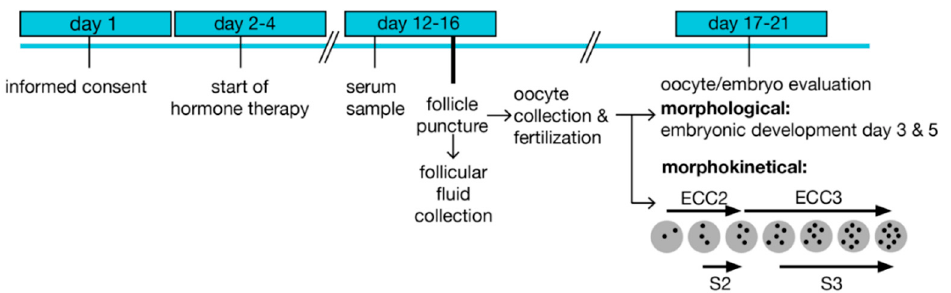
Figure 1. Treatment scheme and sample preparation. Enrolment started on day 1 before the initiation of hormone treatment. A serum sample was prepared prior to follicular puncture and follicular fluid collection. Oocytes and embryos were evaluated based on morphological characteristics, and embryos were cultured in time-lapse systems after fertilization for recording morphokinetic times. ECC; embryo cell cycle, s; synchronization within an ECC. Embryo quality was evaluated at development day 3 with regards to the symmetry of the cells and the percentage of fragmentation. The expansion of the blastocyst, the quality of the inner cell mass (ICM), and the quality of the trophectoderm were determined on embryonic day 5 as described [31]. According to these characteristics, the corresponding FF were divided into five groups (Figure 2). Seventy follicular fluid samples were excluded as no clear allocation to one group was possible due to the presence of more than one oocyte in the corresponding follicle or due to missing information (oocyte sharing), including all the FF samples from two women.